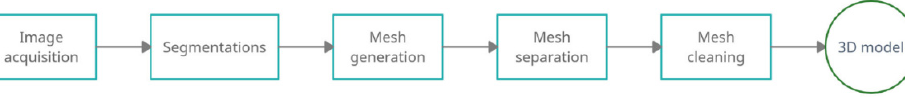
Figure 2. 3D Modelling workflow.